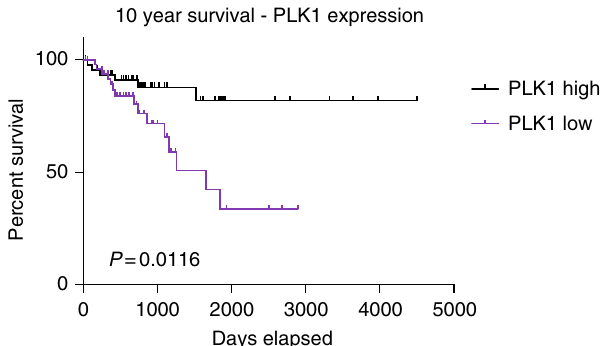
Fig. 9 Overall survival of colon cancer patients according to PLK1 expression. Kaplan-Meier survival data (overall survival) for patients with colon cancer, separated by PLK1 expression (PLK1-high, PLK1-low groups are de fi ned by median of FPKM values). ( p -value of 0.011, based on log rank Mantell-Cox test, Graphpad